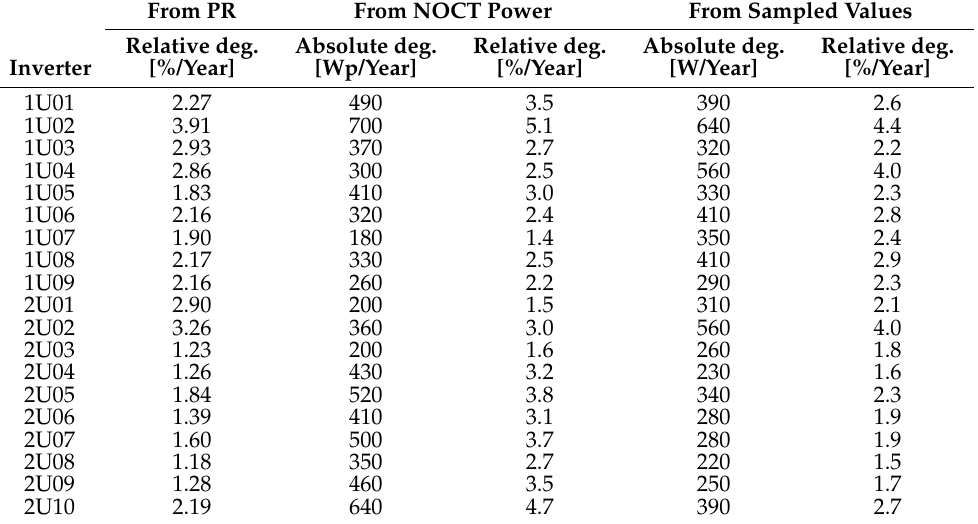
Table 2. Yearly degradations for plant C. From PR From NOCT/STC Power From Sampled Values Relative deg. Absolute deg. Relative deg. Absolute deg. Relative